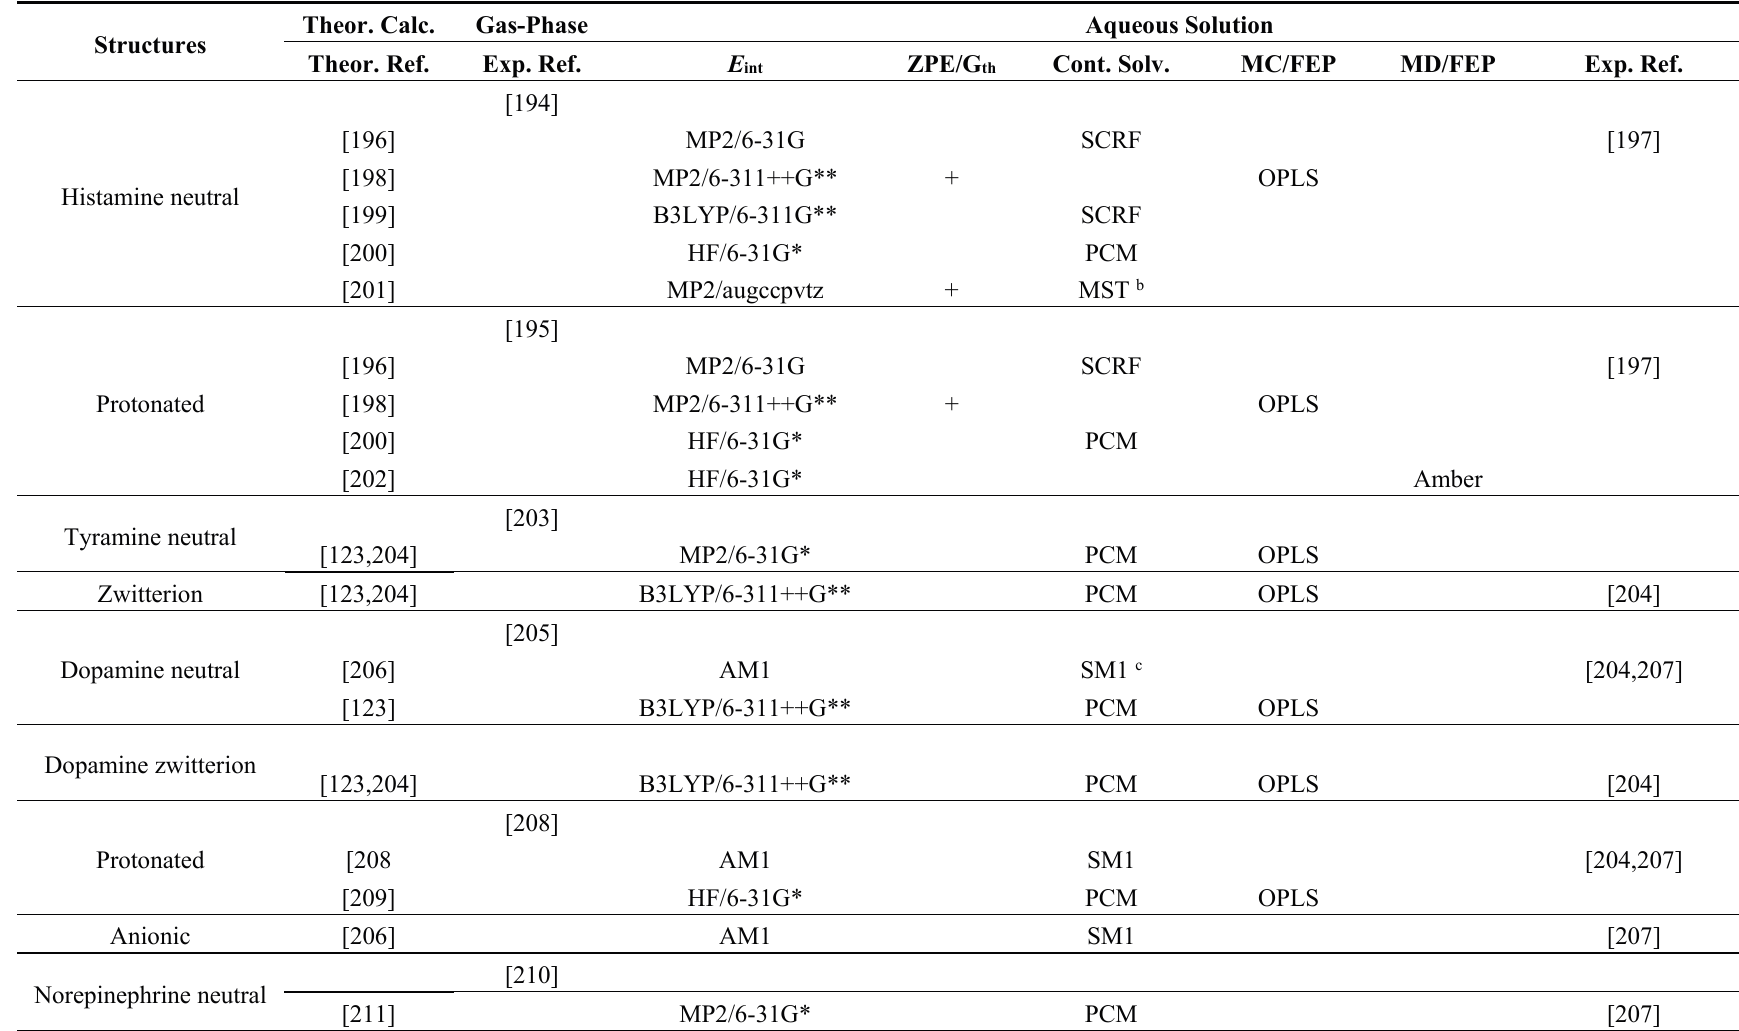
Table 2. Comprehensive summary of the applied experimental and theoretical methods for the conformational/tautomeric equilibria of neurotransmitters in aqueous solution a . Theor. Calc. Gas-Phase Aqueous Solution Structures Theor. Ref. Exp. Ref. E int ZPE/G th Cont. Solv. MC/FEP MD/FEP Exp. Ref.